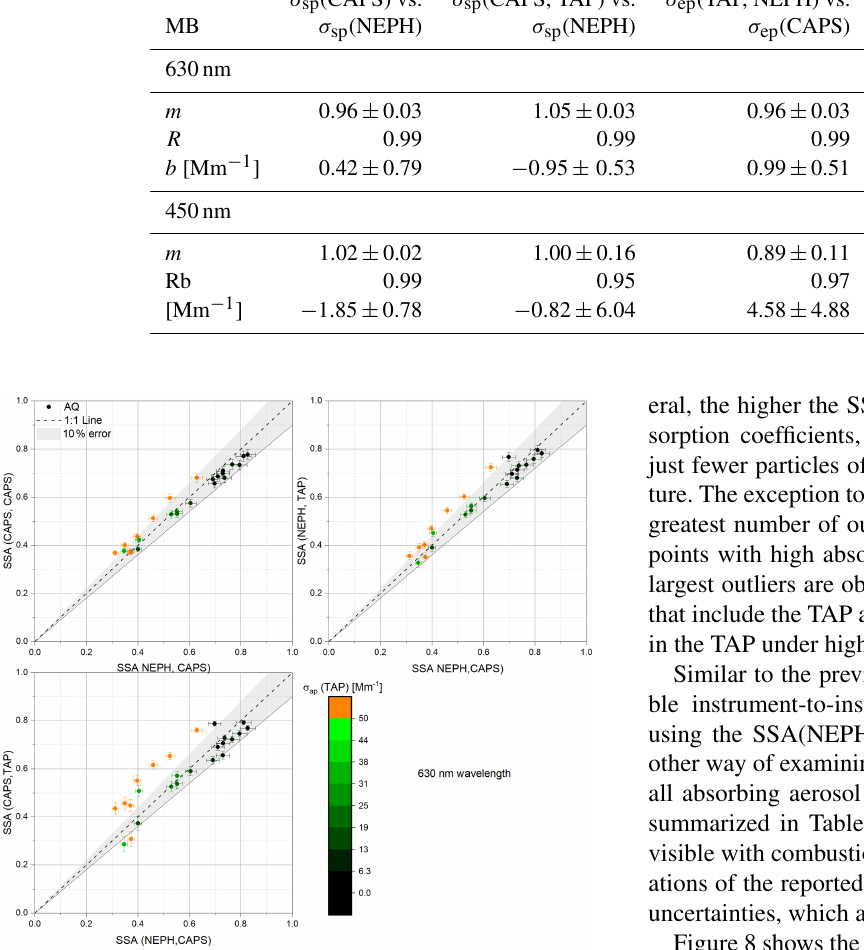
Figure 7. Scatter plots of derived SSA values from various combi- nations of measurements at 630nm wavelength obtained for AQ– AS mixtures ( y axis) versus SSA(NEPH, CAPS) as the reference on the x axis. The colour code indicates σ ap (TAP) values shown in inverse megametres (Mm − 1